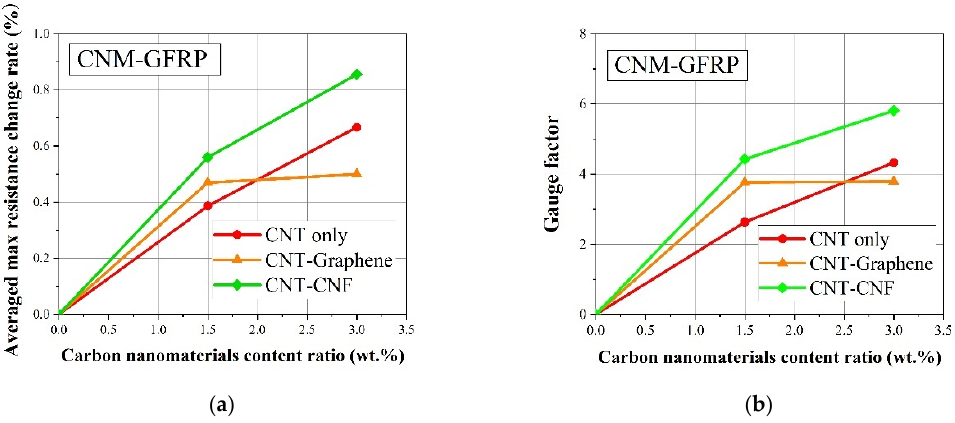
Figure 9. ( a ) Average maximum electrical resistance rate and ( b ) gauge factor of the CNM-incorporated GFRP composites.